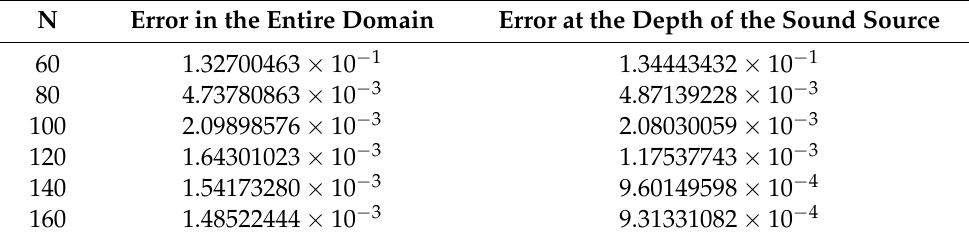
Table 3. The numerical calculation error of the entire solution domain and the depth of the sound source vary with N .